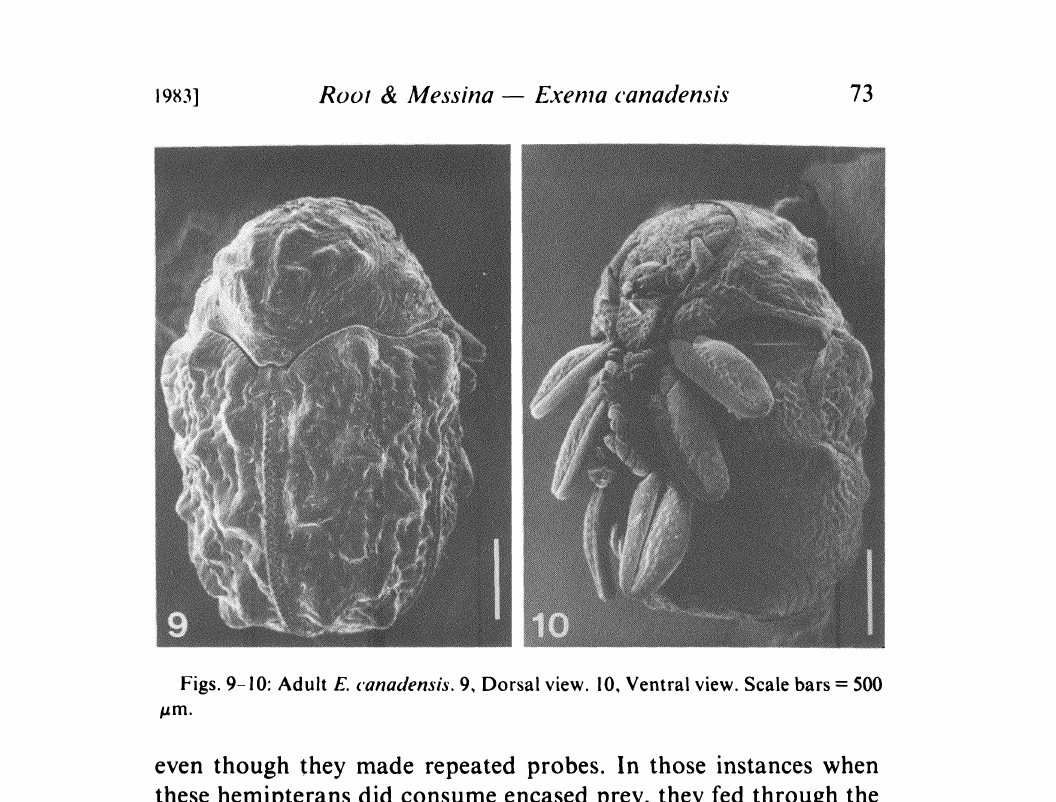
Figs. 9-10: Adult E. canadensis. 9, Dorsal view. 10, Ventral view. Scale bars 500